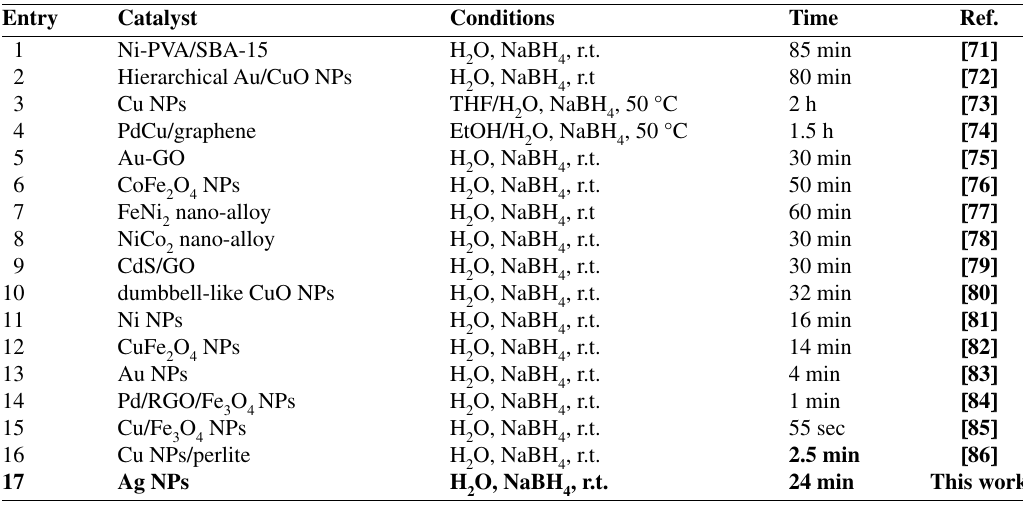
Table 2. Comparison of the result obtained for the reduction of 4-NP in the present work with those obtained by some repor- ted catalysts. Entry Catalyst Conditions Time